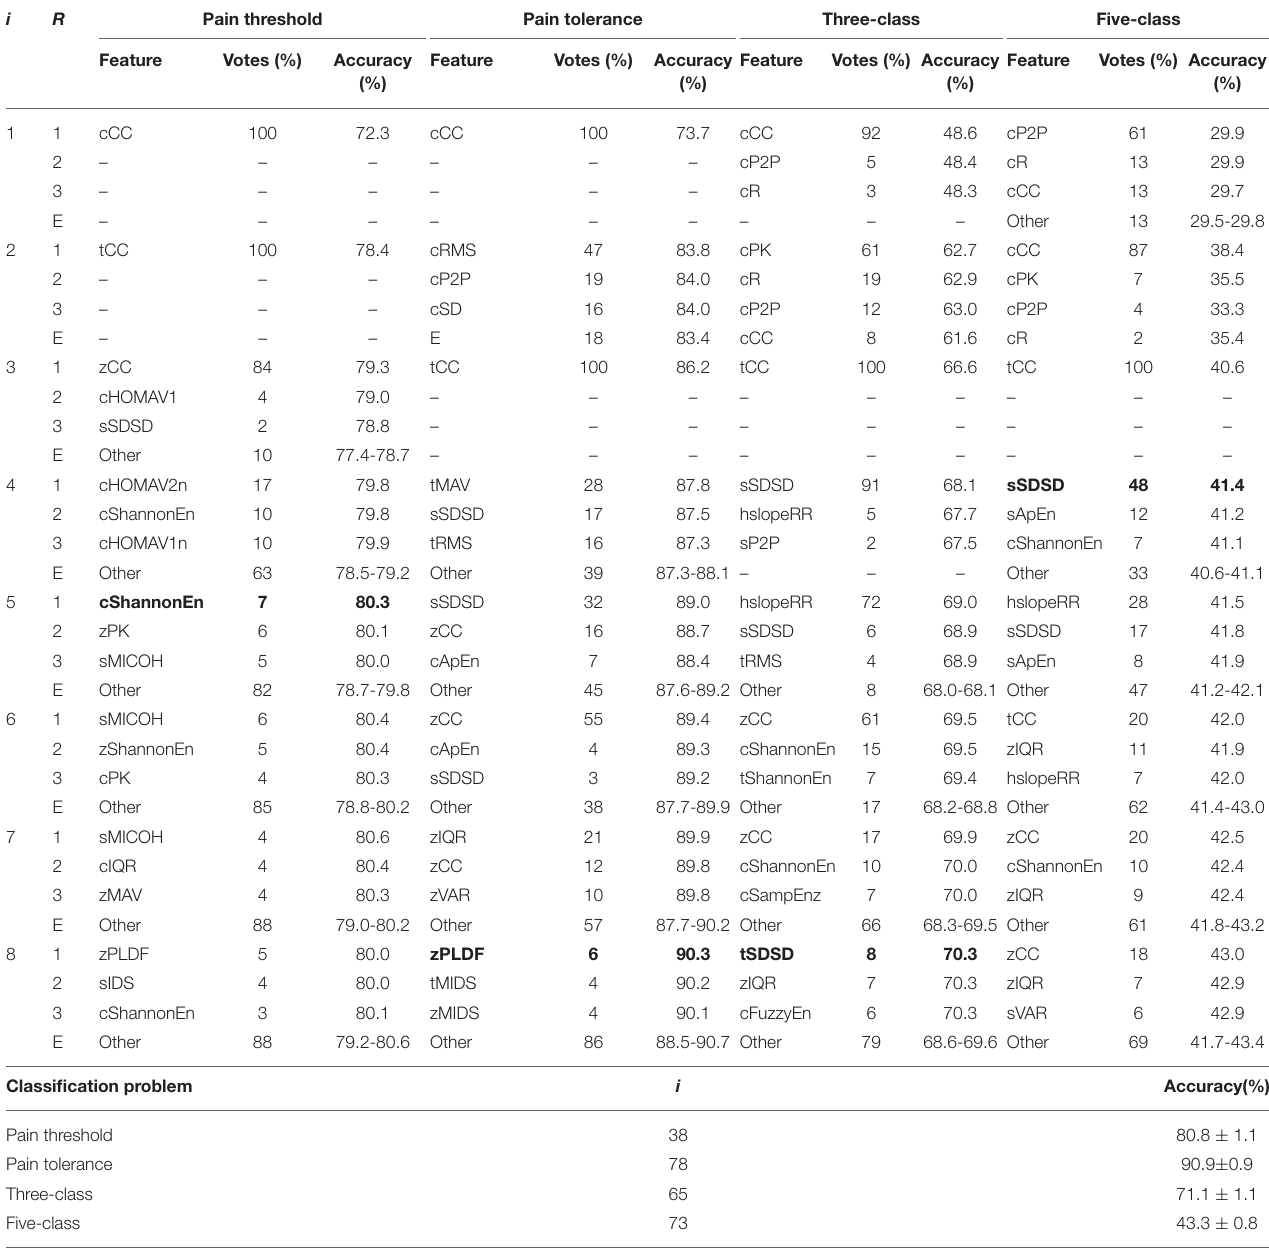
TABLE 3 | Classification performance of the three most frequently selected features for each SFS